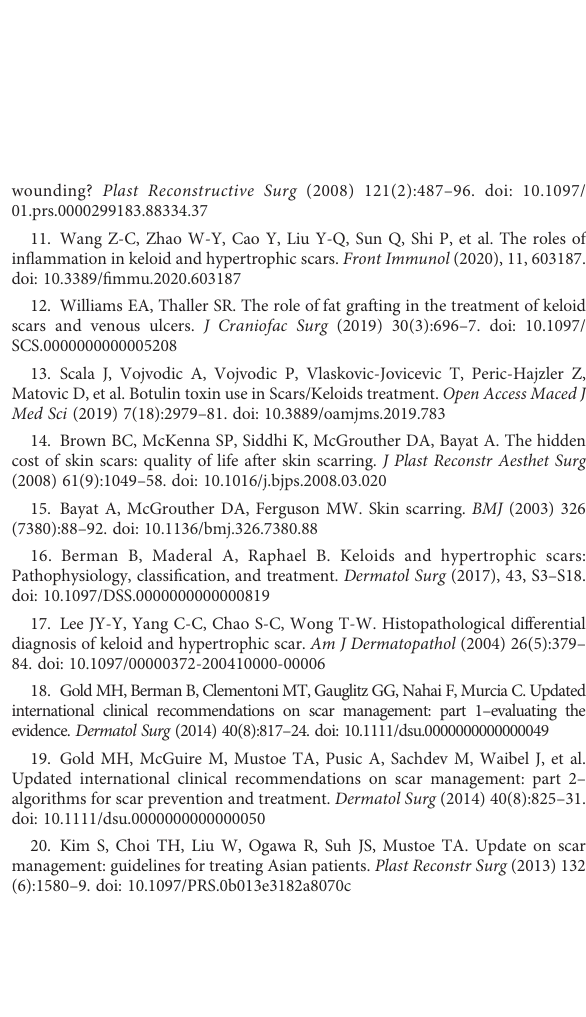
SUPPLEMENTARY TABLE 1 Details of the immune-related